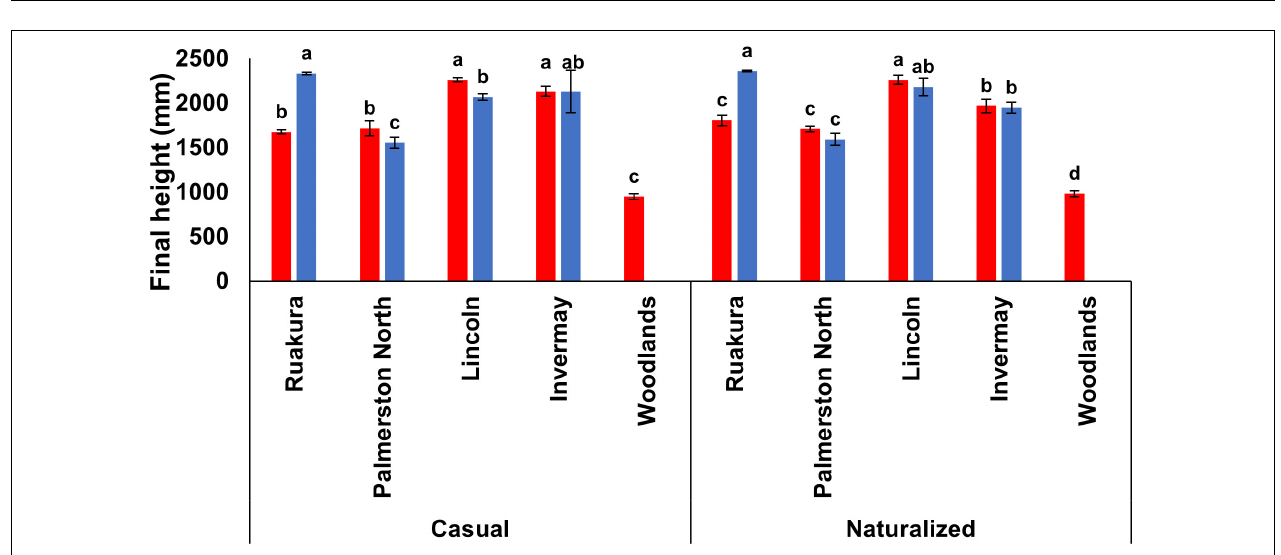
FIGURE 4 | Plant height at flowering for the casual and naturalized populations of A. theophrasti in five different regions of New Zealand in the first (red bars) and second (blue bars) experiments. In the second experiment, plants in Woodlands died after emergence. For each population, vertical bars of the same colour with different letters are significantly different at 5% probability. The error bars represent ± standard error of the mean.